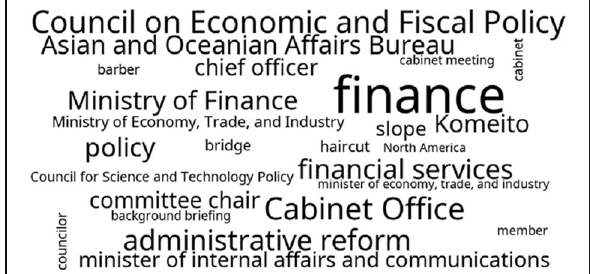
Fig. 11 Word cloud of economic policy